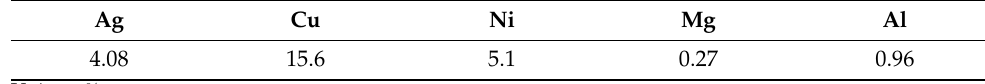
Table 2. Composition of the industrial dust used in the study. Ag Cu Ni Mg Unit: